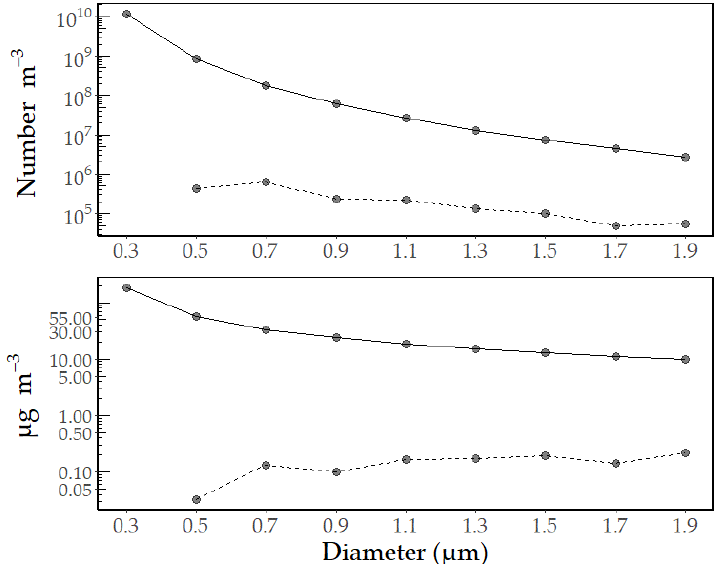
Figure 2. Inferred size distribution of the number and mass concentration of total ambient particulates (solid line) and microbial cells (dashed line). Standard error of the mean = ±10%, n = 4.